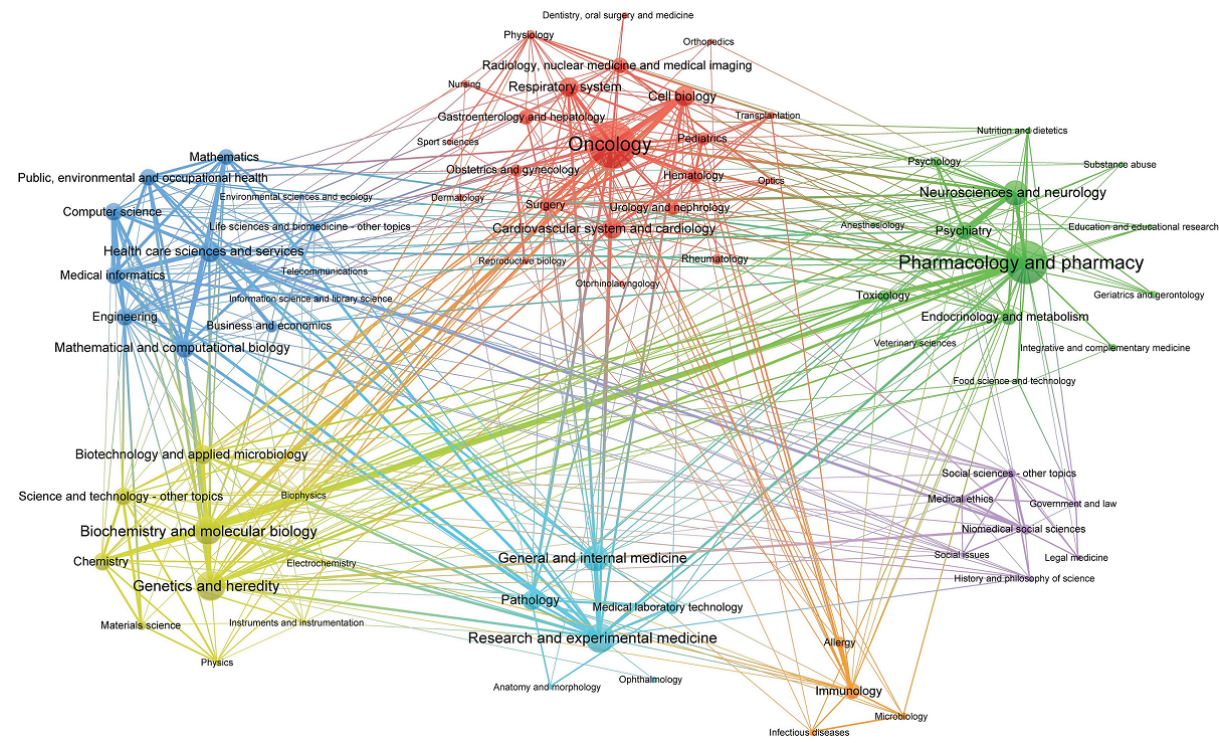
Figure 5. Interdisciplinary structure of all disciplines in precision medicine research.